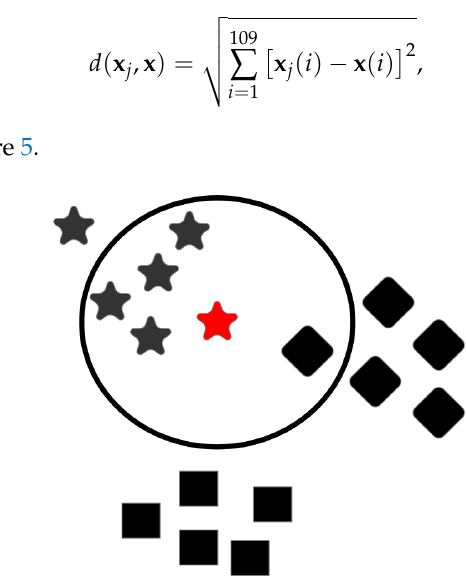
Figure 5. Sketch of the K -NN classifier space using five neighbors. The red star represents the test point. The black stars, squares, and diamonds are the training